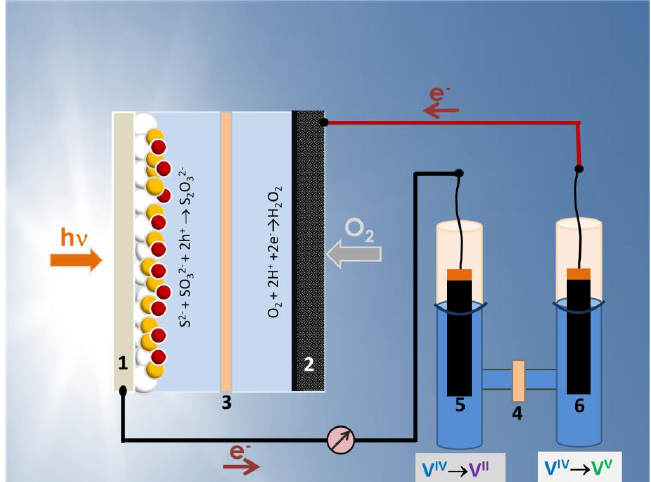
Figure 1. Schematic illustration of the photocatalytic fuel cell (left), the vanadium redox battery (right) and their connection: (1) photoanode; (2) air cathode; (3,4) ion transfer membranes; (5,6) carbon paper electrodes. Before charging, the battery cell is symmetric. After charging, the electrolyte associated with electrode (5) is reduced while the electrolyte associated with electrode (6) is